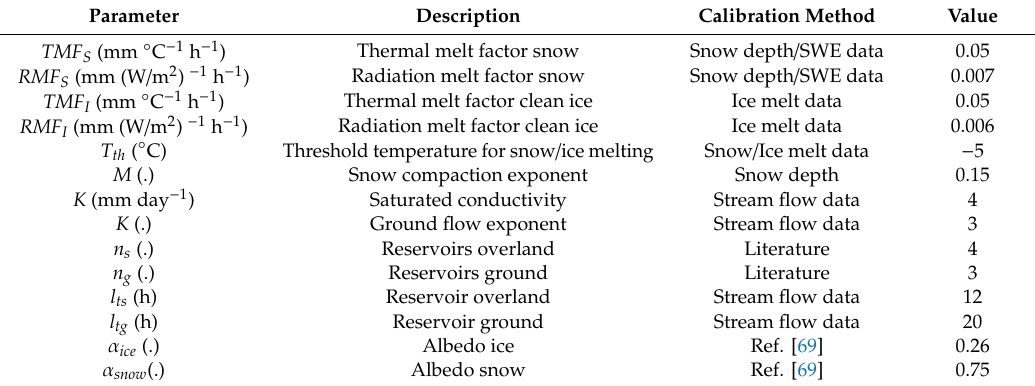
Table 3. Poli-Hydro model parameters, calibration methods, and